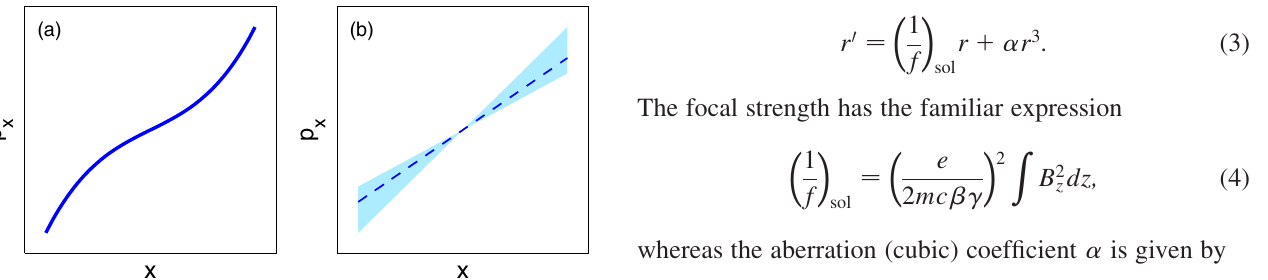
ffiffiffi p 8 = 3 for Gaussian, ellip-